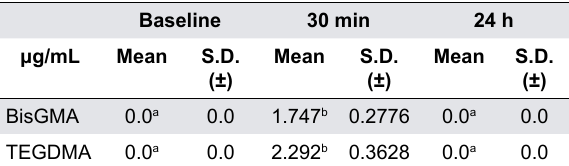
Table 1- Analysis of levels of BisGMA and TEGDMA in the saliva of children using spur as a treatment to anterior open bite. A total of 22 children participated in this study. Friedman followed by Dunn’s Multiple Comparison Test. p<0.05 was considered statistically significant. Different letters mean the statistical difference among groups